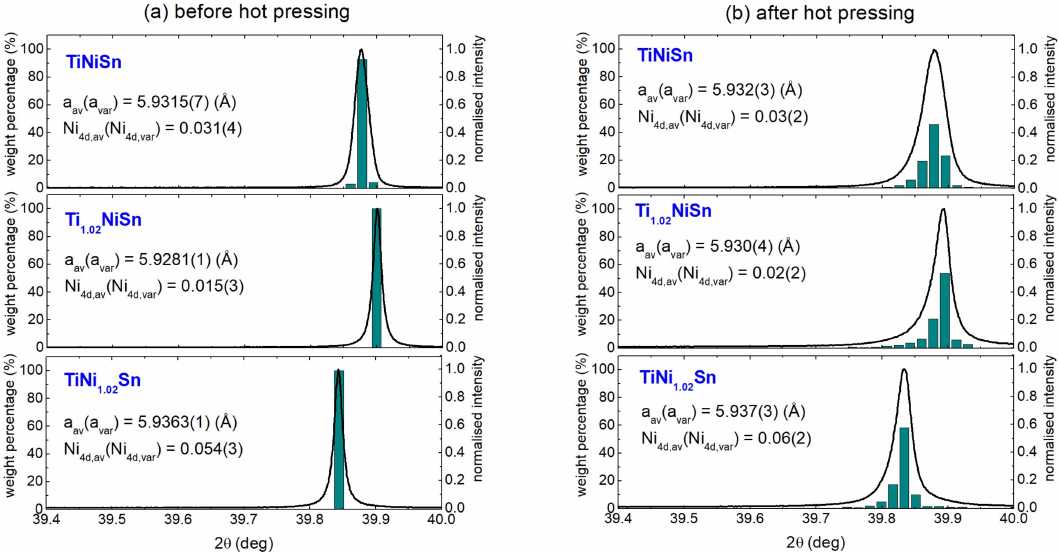
Figure 3. Close-up of the (422) reflection in synchrotron X-ray powder diffraction for the TiNiSn, Ti 1.02 NiSn, and TiNi 1.02 Sn samples ( a ) before and ( b ) after hot pressing. The green histograms indicate the HH phases used to fit the peak shape. The average lattice parameter (a av ), peak broadening (a var ), average Ni 4d occupancy (Ni 4d,av ), and variance of the Ni 4d occupancy (Ni 4d,var ) are shown as a av (a var ) and Ni 4d,av (Ni 4d,var ) in the panels. Peak intensities have been normalised and data are plotted against 2 θ